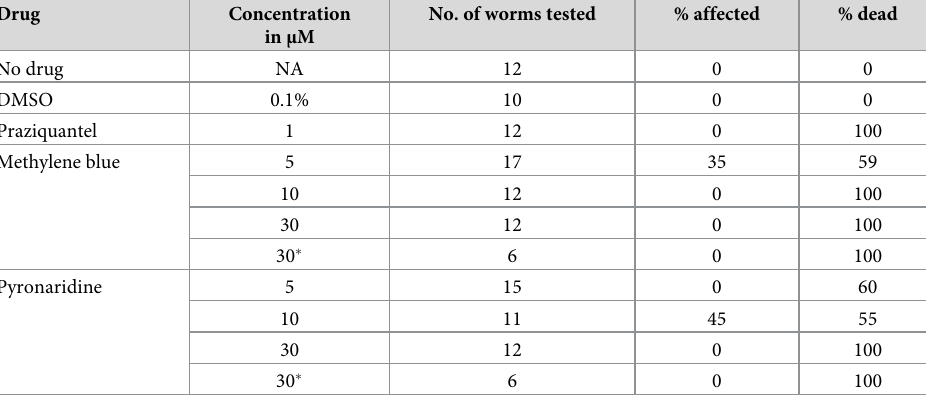
There is an error in Table 2. The line shifted some data into the incorrect drug candidates. Please see the correct Table 2 here. Table 2. Drug activity against ex vivo adult worms (step 2). Drug Concentration in µ